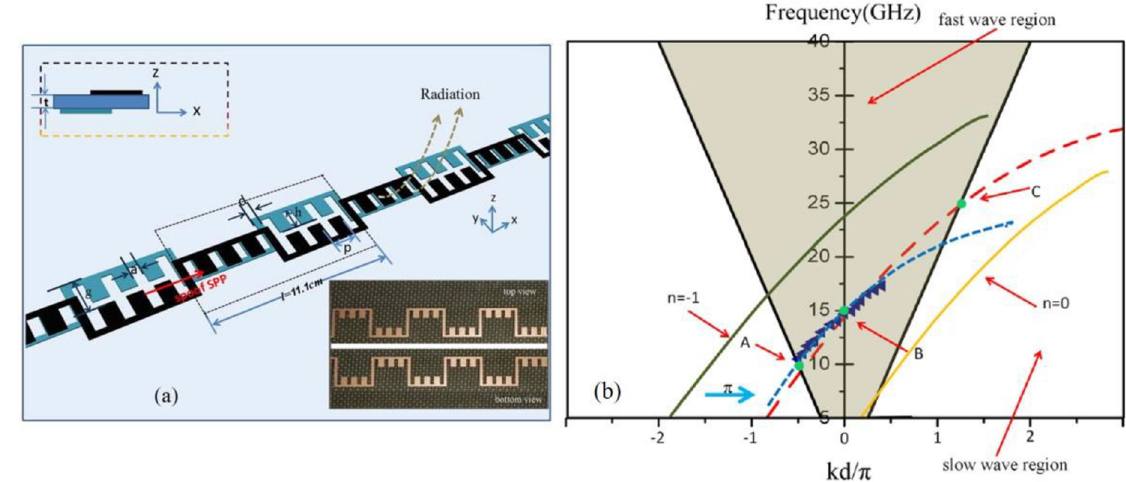
Fig. 4. (a) Structure for the diffraction radiations with phase-reversal geometry. (b) The Brillouin diagram (vs. frequency)